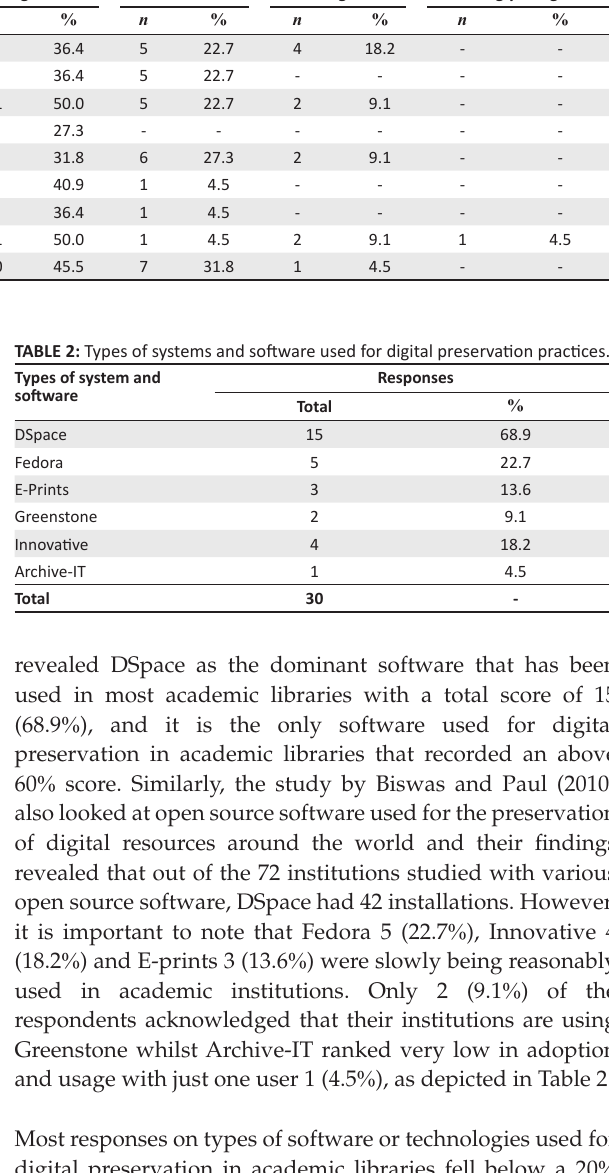
TABLE 1: Motivation for digital preservation. Motivation for digital